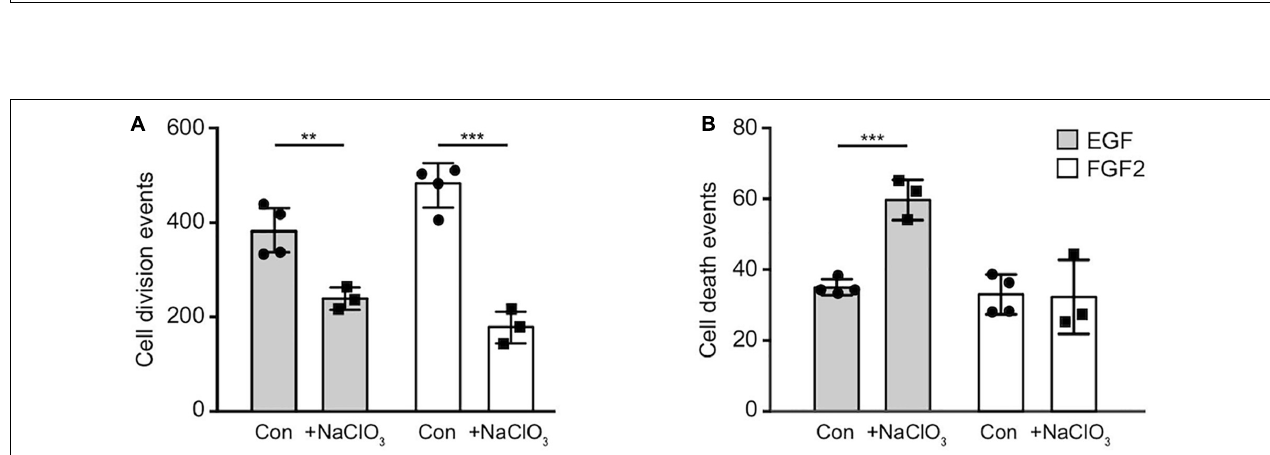
FIGURE 2 | Expression analysis of RPTP- β / ζ /DSD-1-PG and CS-/DS-sulfotransferases in the developing spinal cord. (A) RT-PCR analysis revealed the presence of DSD-1-PG/phosphacan and RPTP- β / ζ mRNAs in tissue isolated from E15.5 spinal cords (E15.5 SC). The isoforms could be detected individually using primers located in the specific sequences of the mRNA (Garwood et al., 1999). (B) The mRNA of the ptprz1 gene coding for a constant part of the RPTP- β / ζ and DSD-1 proteoglycan sequences was produced by cells surrounding the central canal, as could be seen by in situ hybridizations. Sections that were incubated with the sense riboprobe did not show any positive signals (insert). (C) Chst11, Chst12, Chst13, Chst3, and Chst7 as well as Chst15 and Ust genes could be detected in E15.5 spinal cord mRNA via RT-PCR. A representative spinal cord sample is shown together with the no-template control (H 2 O) and a positive control consisting of cDNA from neurospheres derived from embryonic brain tissue (Akita et al., 2008). Interestingly, although not present in telencephalic mRNA Chst13 could be detected in E15.5 spinal cord tissue. β -Actin served as the reference gene. (D) Representative in situ hybridizations on E15.5 spinal cord sections showed positive signals for Chst3, Chst7, Chst11, and Ust in the central and intermediate zones of the spinal cord, but not in the marginal layer. Sulfotransferase message could be detected in the ventral as well as the dorsal spinal cord and the DRG. Sense controls (inserts) did not show detectable signals. Scale bars: 200 µ m.